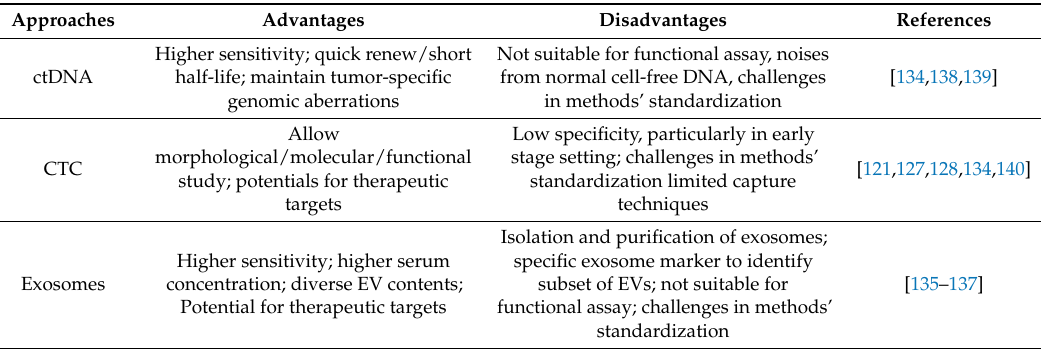
Table 4. Advantages, disadvantages of ctDNA, CTC, and exosome as